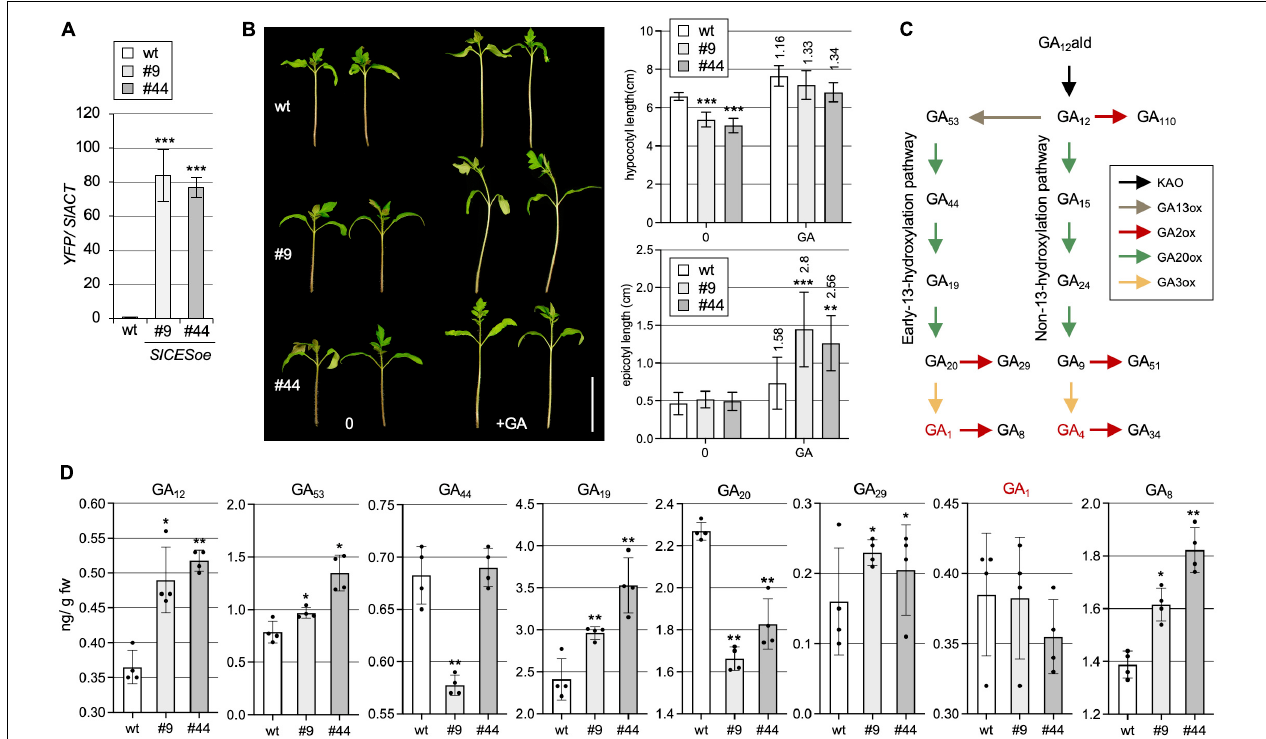
FIGURE 2 | SlCES over-expression alters GA homeostasis. (A) Expression of SlCES-YFP in two independent over-expression lines (#9 and #44) as compared to wild-type Heinz 1706 (wt). YFP was detected by RT-qPCR in vegetative tissues of the lines. Data show the mean ± SD. n = 4 biological repeats, each measured in 3 technical replicates, normalized to SIACT . (B) Phenotype (left) and quantification of hypocotyl and epicotyl length (right) of 14-day-old, soil-grown plants of the two SlCESoe lines with or without GA treatment. Plants were grown in the incubator in standard growth conditions for 7 days and then treated with DMSO as a control (0), or with 50 µ M GA 4 + 7 (GA), once a day for another 7 days, before hypocotyl and epicotyl length was measured. The results are shown as means ± SD ( n > 12). The ratio of treated versus untreated is shown. White bar = 5 cm. (C) Illustration of the GA biosynthetic pathway. Different enzyme classes are shown in different colors. (D) GC-MS measurements of different GAs in aerial parts of 14-day-old plants grown in the incubator in the same conditions as in A. The values are given in ng/g fresh weight. The results of four biologically replicates and mean and standard deviations are shown. In all charts: asterisks indicate significant differences determined by Student’s t -test (* P ≤ 0.05; ** P ≤ 0.01; *** P ≤